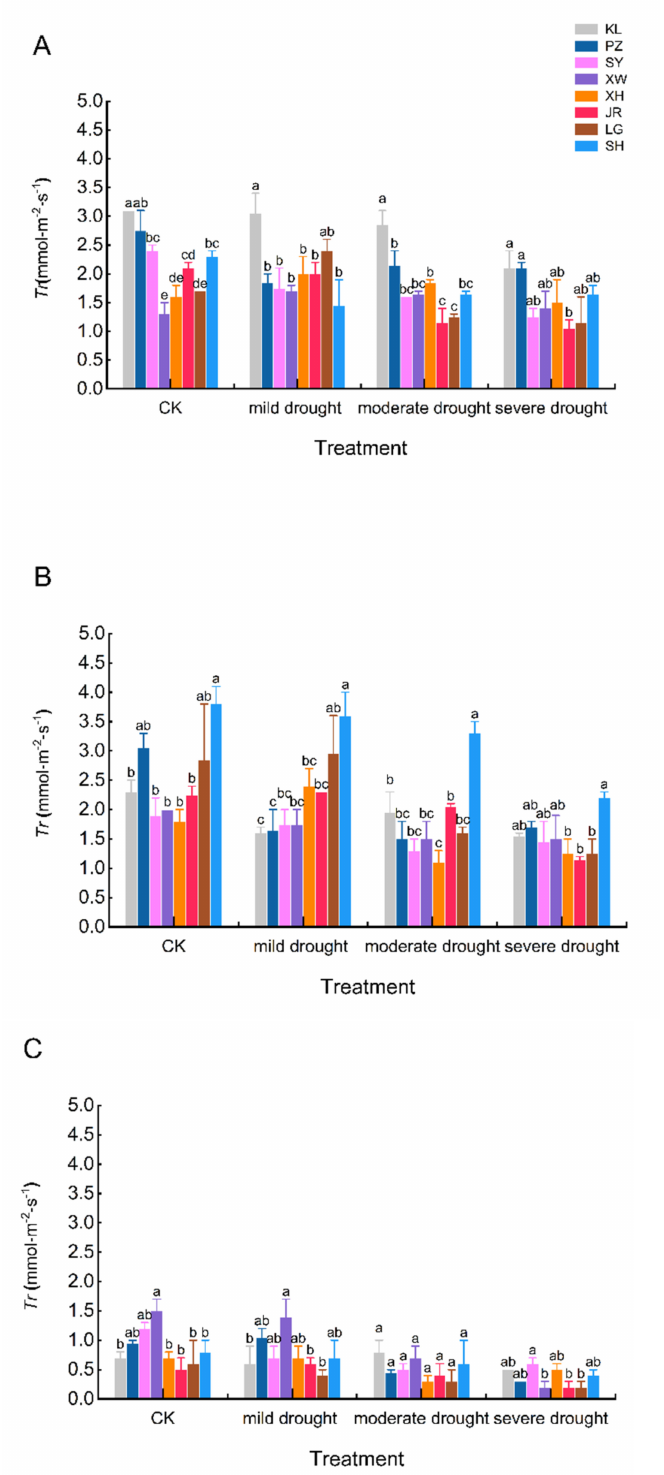
Figure 4. The transpiration rate of Melia azedarach among different provenances: ( A ): early stage, ( B ): middle stage, and ( C ): late stage. Note: The error line in the figure is the mean ± standard error, and different lowercase letters in the same treatment indicate significant differences at the 0.05